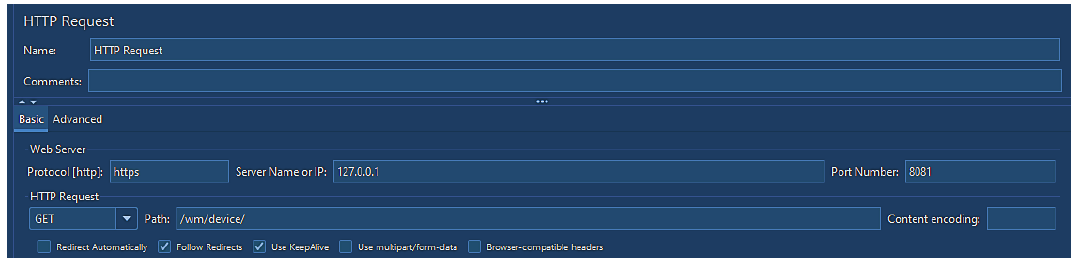
Figure 8. JMeter request to the Floodlight REST